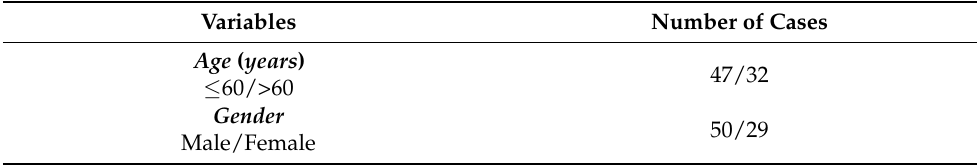
Table 2. Characteristics of patients in